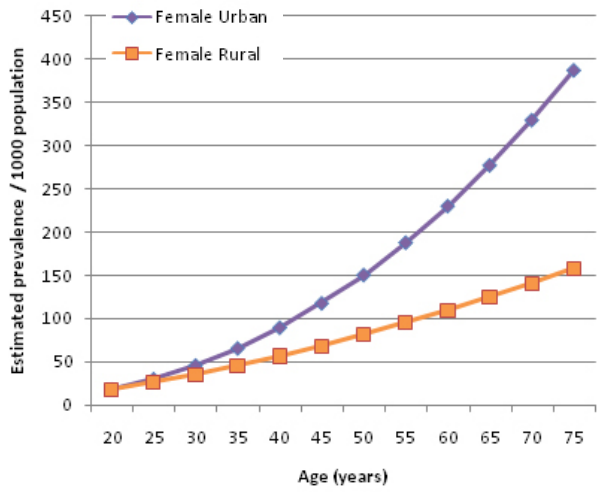
Figure 12. Comparison of the prevalence of type 2 diabetes in Southern Asia by age in urban and rural regions – women only.